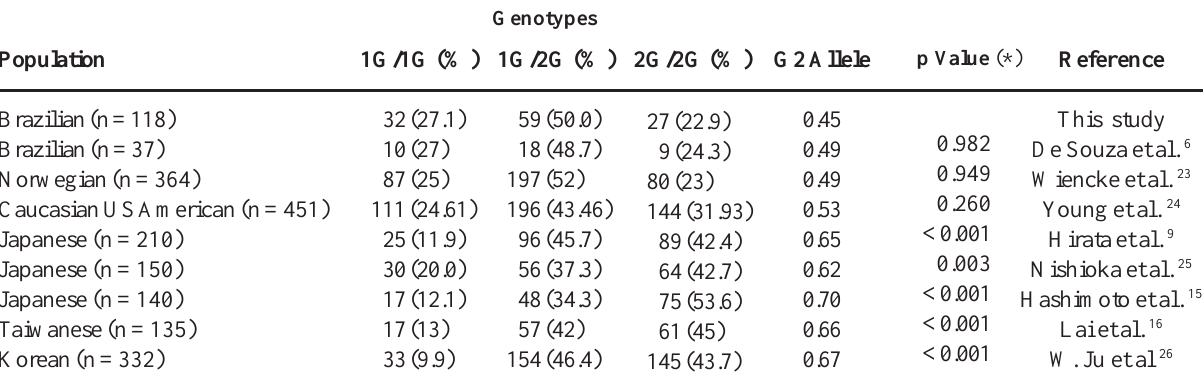
Table 5 – Distribution of genotype and frequency of G2 allele in different